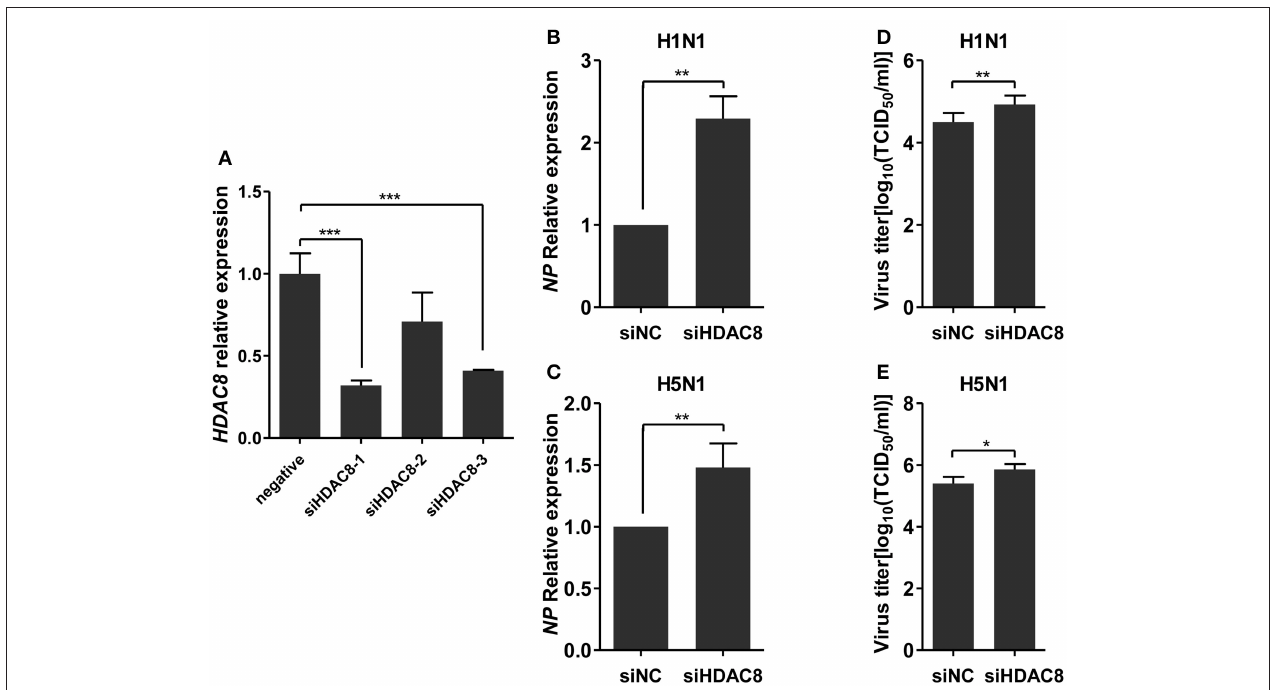
FIGURE 8 | Knockdown of HDAC8 enhances IAV replication. (A) A549 cells were transfected with three different HDAC8 siRNAs (siHDAC8-1, siHDAC8-2, siHDAC8-3) or a negative control siRNA (siNC) at a final concentration of 25nM. After 48h, relative HDAC8 mRNA levels were measured by real-time qPCR and normalized to that of GAPDH . Data are the mean ± SD of triplicate samples from a single experiment and are representative of two independent experiments. *** P < 0.001 by t -test. (B–E) A549 cells were transfected with siHDAC8-1 or siNC at a final concentration of 25nM. Twenty-four hours after transfection, cells were infected with H1N1 or H5N1 at a MOI of 0.1. Viral NP vRNA was analyzed at 48 hpi by real-time qPCR (B,C), and virus titers in supernatants were measured by the TCID50 assay performed on MDCK cells (D,E) . Data are the mean ± SD from four independent experiments. * P < 0.05 and ** P < 0.01 vs. negative control by t